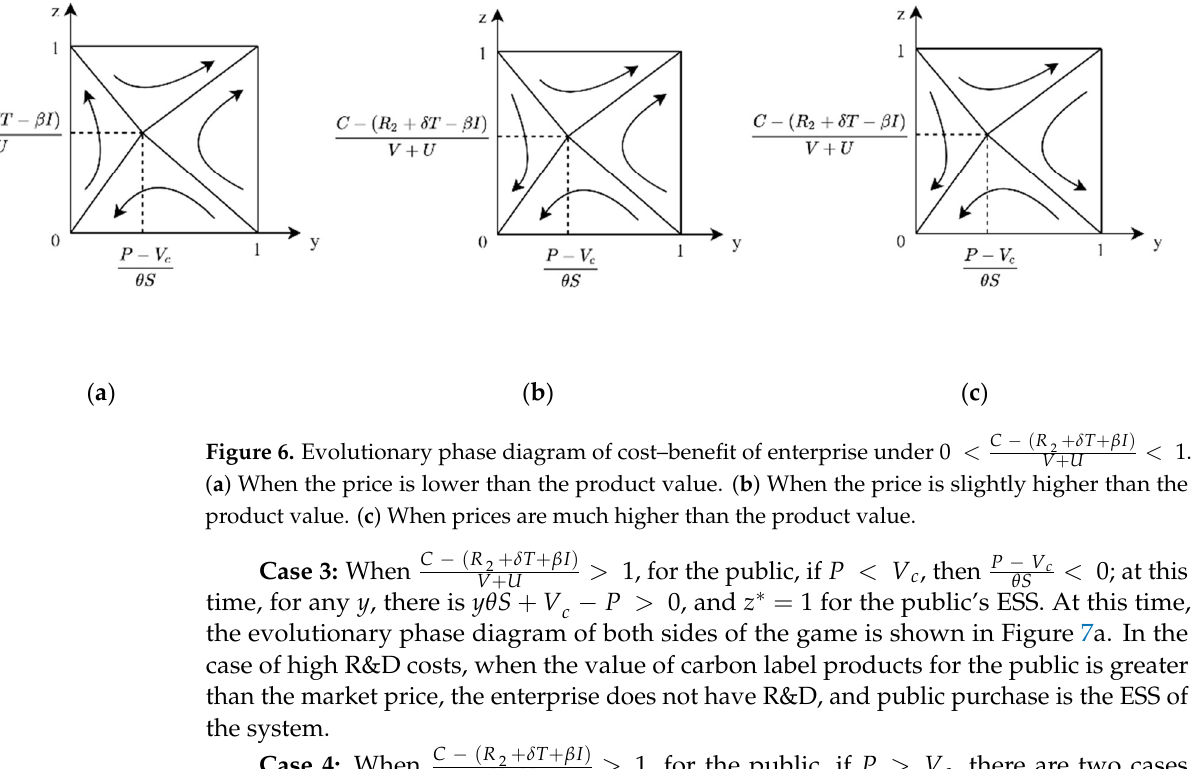
< 1 . ( a ) V + U − ( R + δ T + β I ) < 1 . ( a ) < 1. 2 V + U V + U